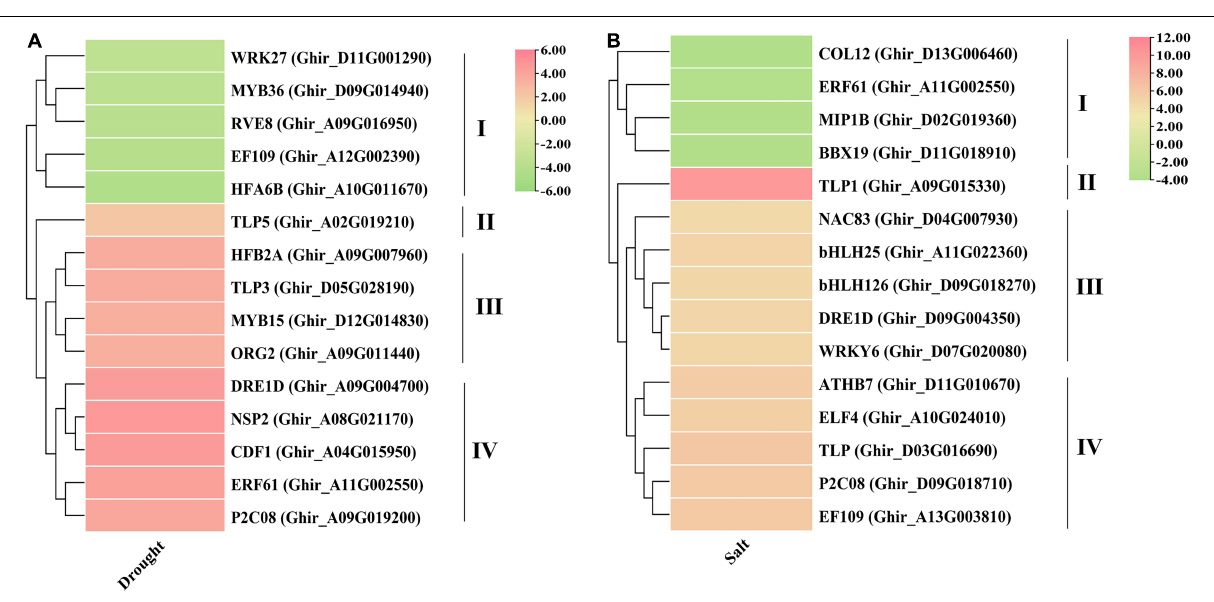
biosynthesis, and sulfur metabolism pathways in which the highest number of genes are involved in the biosynthesis of secondary metabolites ( Figure 7A ) and salt stress, the higher the number of genes is involved in metabolic pathways than in phenylpropanoid biosynthesis and pyruvate metabolism ( Figure 7B